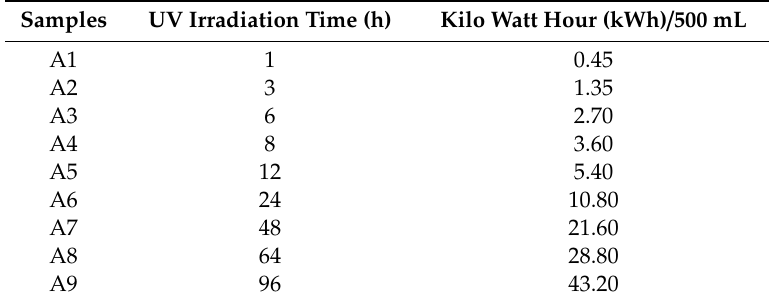
Table 1. Power consumption data for UV irradiation during the synthesis of